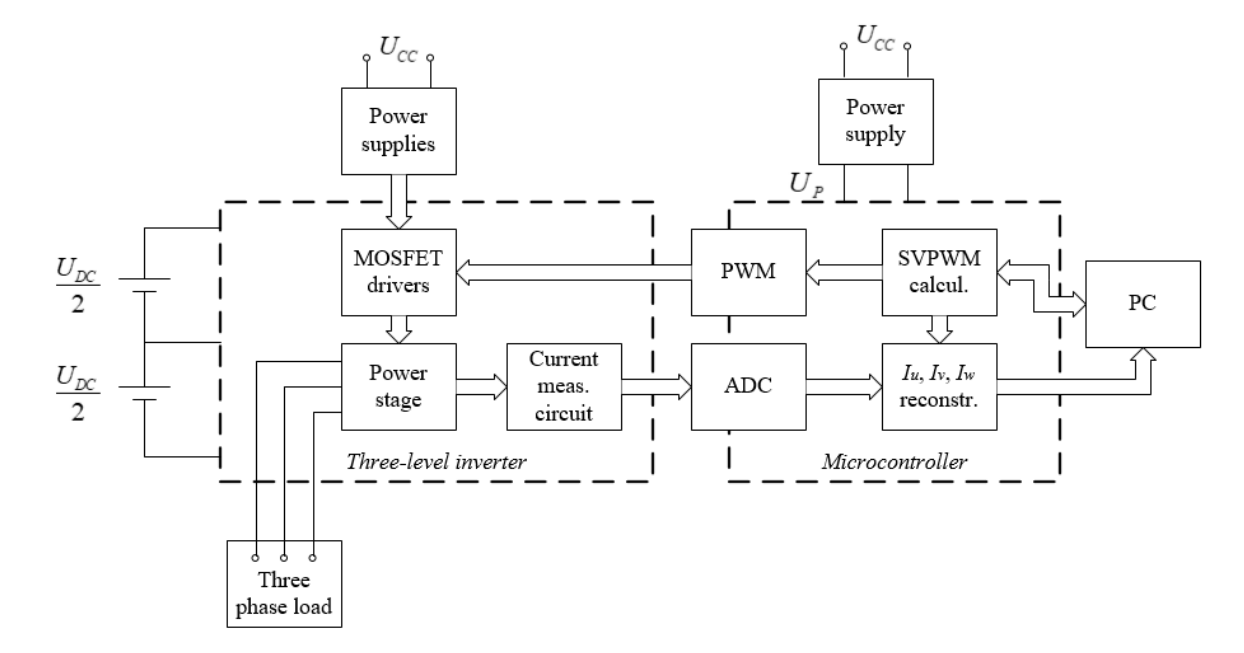
Figure 13. The block scheme of a three-level inverter.